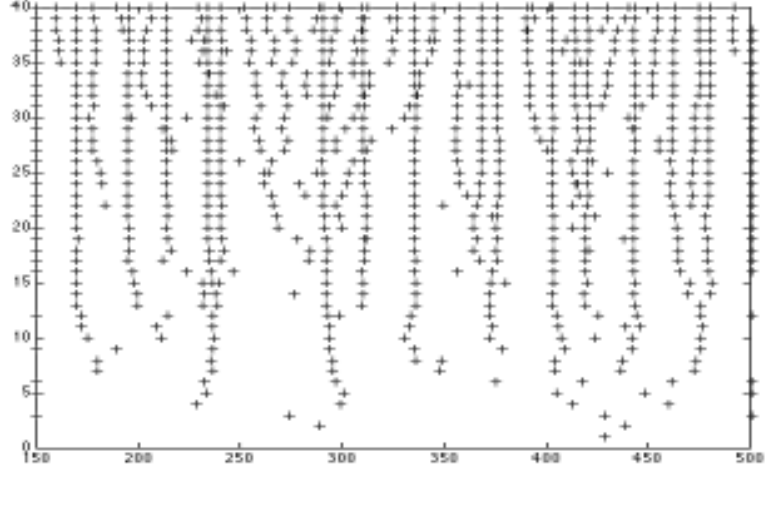
Fig. 5. Stabilization diagram LSCE.